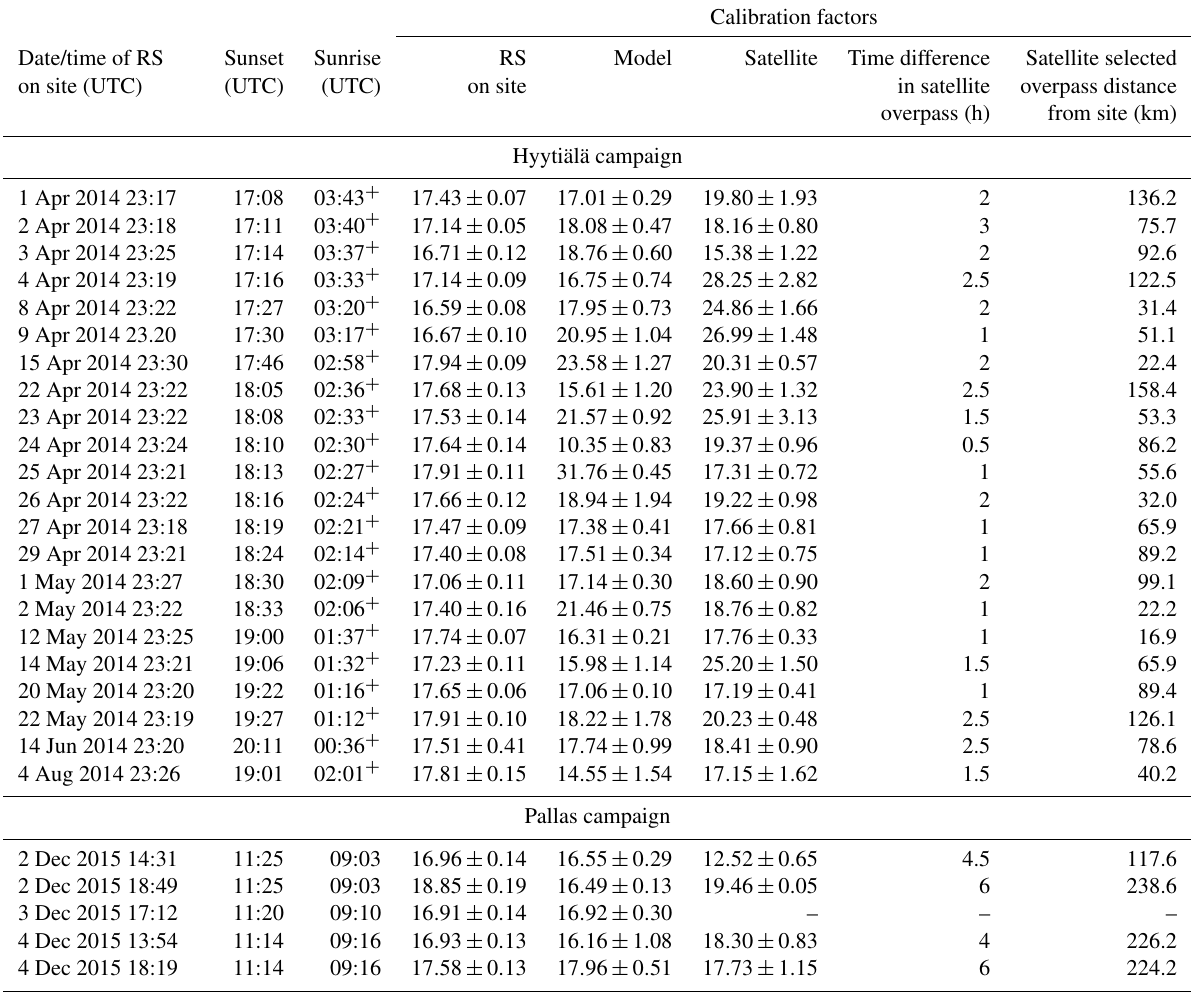
Table 1. Lidar calibration factors and errors derived from RS, satellite and model data during Hyytiälä and Pallas campaign. For satellite overpasses the distance between the lidar site and the selected footprint along with the time difference from the RS launch time is available. Sunrise/sunset times are also